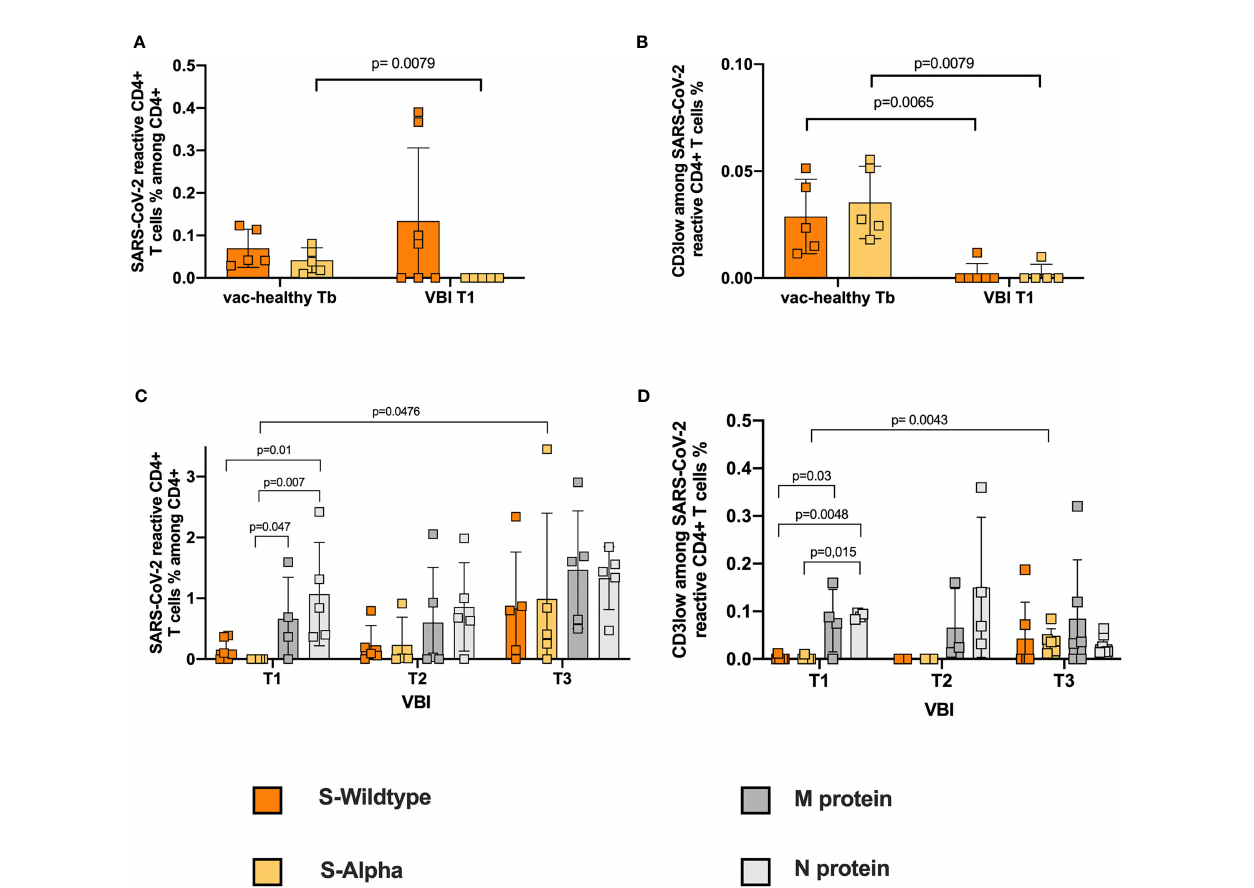
FIGURE 1 | Failure to develop S-reactive CD4+ T cells against the Alpha variant and WT S-reactive CD4+ T cells with high avidity at disease onset. Characterization of SARS-CoV-2 S-reactive CD4+ T cells in diseased and healthy subjects. Blood samples of 8 diseased patients with SARS-CoV-2 breakthrough infection and 5 healthy vaccinated patients were stimulated with SARS-CoV-2 S-WT, S-Alpha, M- and N-proteins, and analyzed by fl ow cytometry. (A, B) S-WT and S-Alpha reactive CD4+ T cells and their avidity between control at Tb and diseased at T1. Absence of Alpha reactive CD4+ T cells at disease onset, accompanied by presence of WT reactive CD4+ T cells with no avidity. (C, D) Quanti fi cation of S-WT, S-Alpha, M- and N-reactive CD4+ T cells among the diseased. Statistically signi fi cant strong frequencies of M- and N- reactive T cells compared to S-WT and S-Alpha reactive T cells at disease onset, with signi fi cant higher avidity. Generation of reactive CD4+ T cell response against all 4 SARS-CoV-2 proteins at T3. Reactive SARS-CoV-2 CD4+ T cells are de fi ned as CD4+CD154+CD137+ cells. The avidity was determined by detecting CD3low+CD4+ T cells among CD4+CD154+CD137+. Negative controls were subtracted from reactive stimulated samples to exclude unreactive activation. Bars show mean and standard deviation. Paired data was compared with Wilcoxon matched pairs test, whereas unpaired data with Mann-Whitney-test. P<0.05 was considered signi fi cant, only signi fi cant p values are documented in the fi